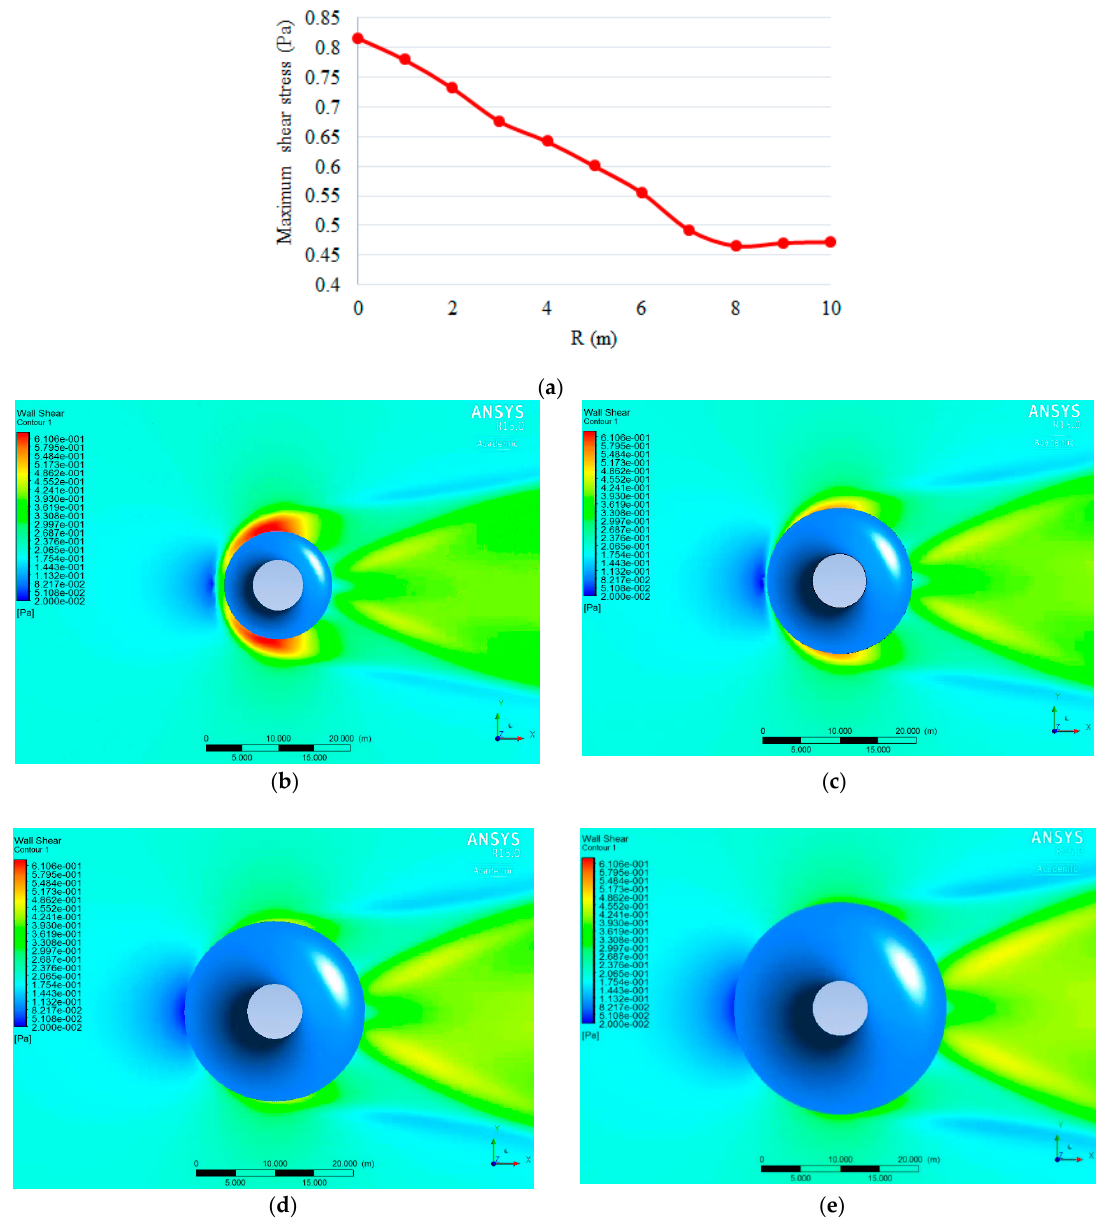
Figure 14. Variation of seabed shear stress vs. different sizes of the SEMCD: ( a ) Variation tendency of the maximum shear stress vs. the increasing R ; ( b ) shear stress contour when R = 4 m; ( c ) shear stress contour when R = 6 m; ( d ) shear stress contour when R = 8 m; ( e ) shear stress contour when R = 10 m.